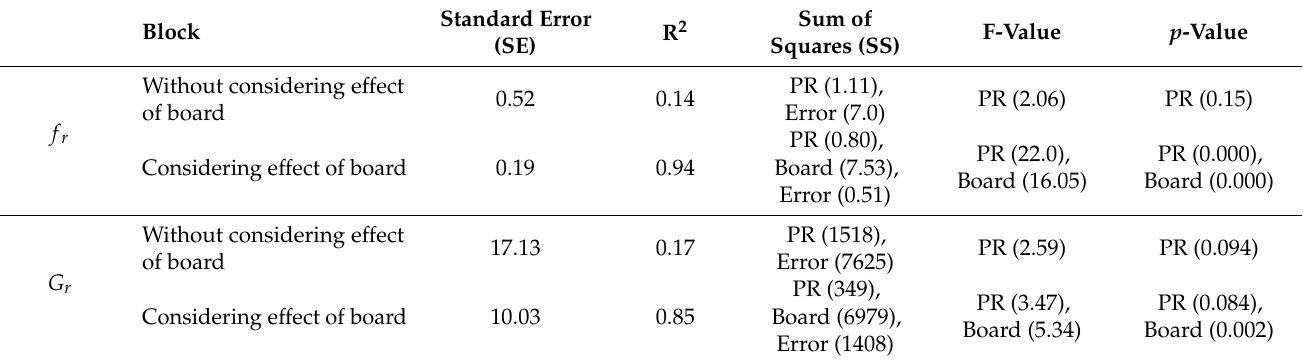
Table 10. Effect of projection length on the RS properties (southern pine) for f r and G r ,